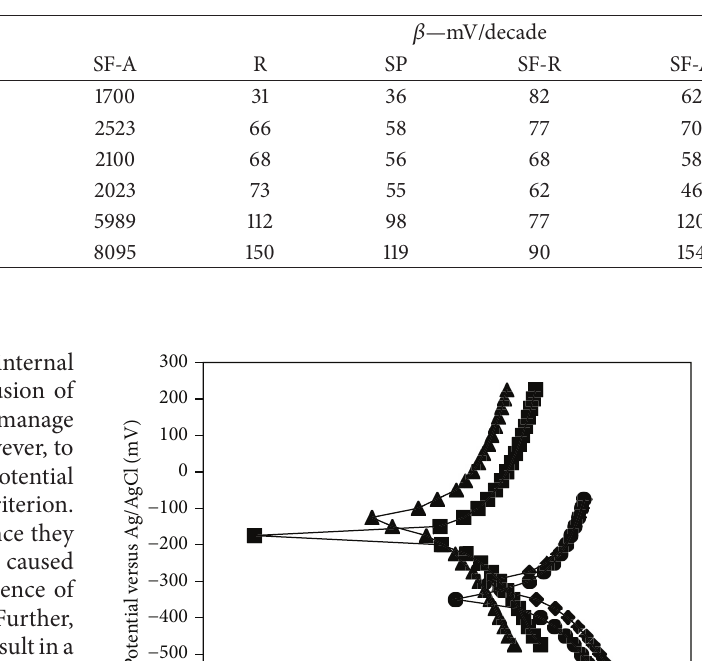
Table 4: Polarization resistance and proportionality constant.